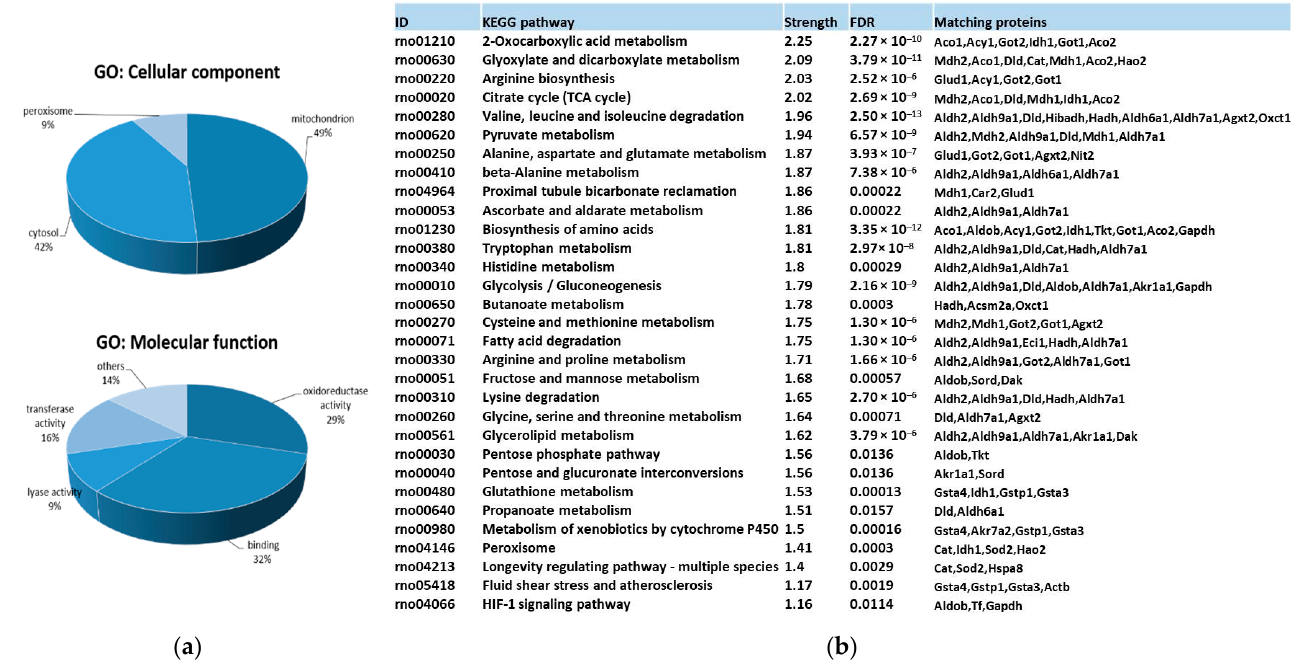
Figure 2. Functional enrichment analysis for carbonylated proteins identified in the kidney. ( a ) Significantly enriched GO terms according to cellular component and molecular function in carbonylated proteins of rat kidney. GO enrichment analysis were conducted by using gProfiler. ( b ) KEGG pathway enrichment analysis for carbonylated proteins in rat kidney. KEGG pathway enrichment was conducted by using STRING. Strength: Log10 (observed proteins to be annotated with a term in the interaction network created with the proteins of interest/expected proteins to be annotated in a random network of the same size). FDR: False Discovery Rate. Significant enrichment at FDR < 5%.